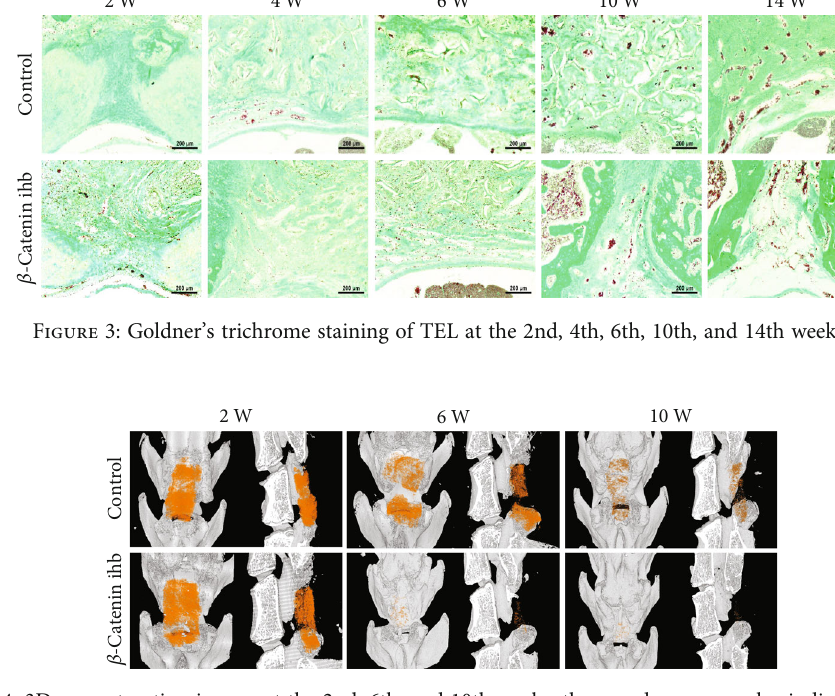
Figure 4: 3D reconstruction images at the 2nd, 6th, and 10th weeks; the pseudo orange color indicates the TEL.